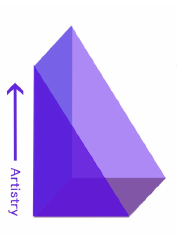
Fig. 1 Artistic forward right triangle.